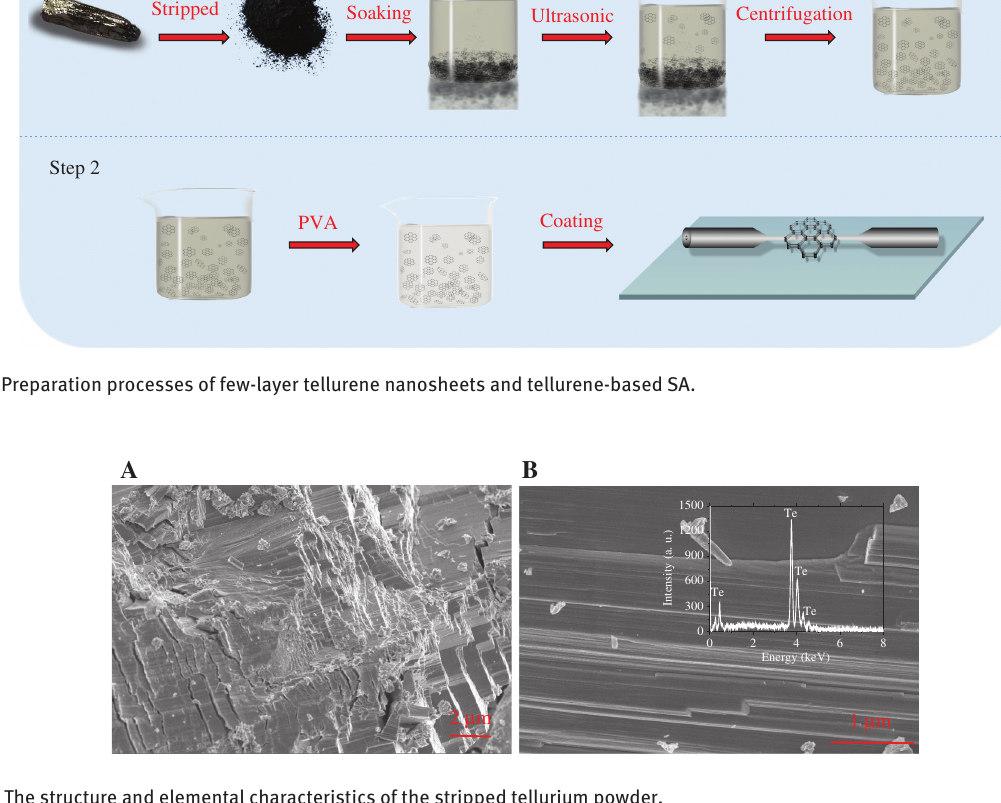
Figure 2: The structure and elemental characteristics of the stripped tellurium powder. SEM images of bulk tellurium recorded under a resolution of (A) 2 μ m and (B) 1 μ m. (Inset of B) EDS of bulk